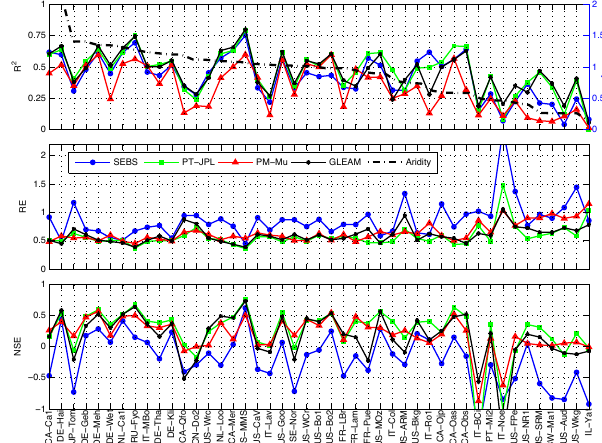
Figure A2. Comparison of the performance skill of the models in reproducing evaporation for the grid-based analyses. R 2 is the co- efficient of determination, RE is relative error (lower is better) and NSE is the Nash–Sutcliffe efficiency (higher is better). Towers are arranged from left to right based on an aridity index (secondary y